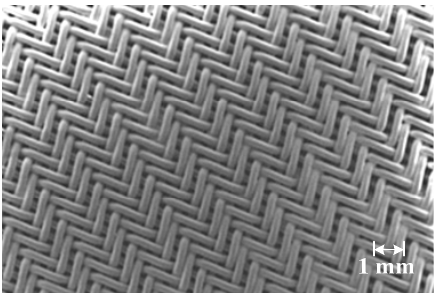
Figure 1. Microstructure of the PA66 fabric observed by scanning electron microscope.